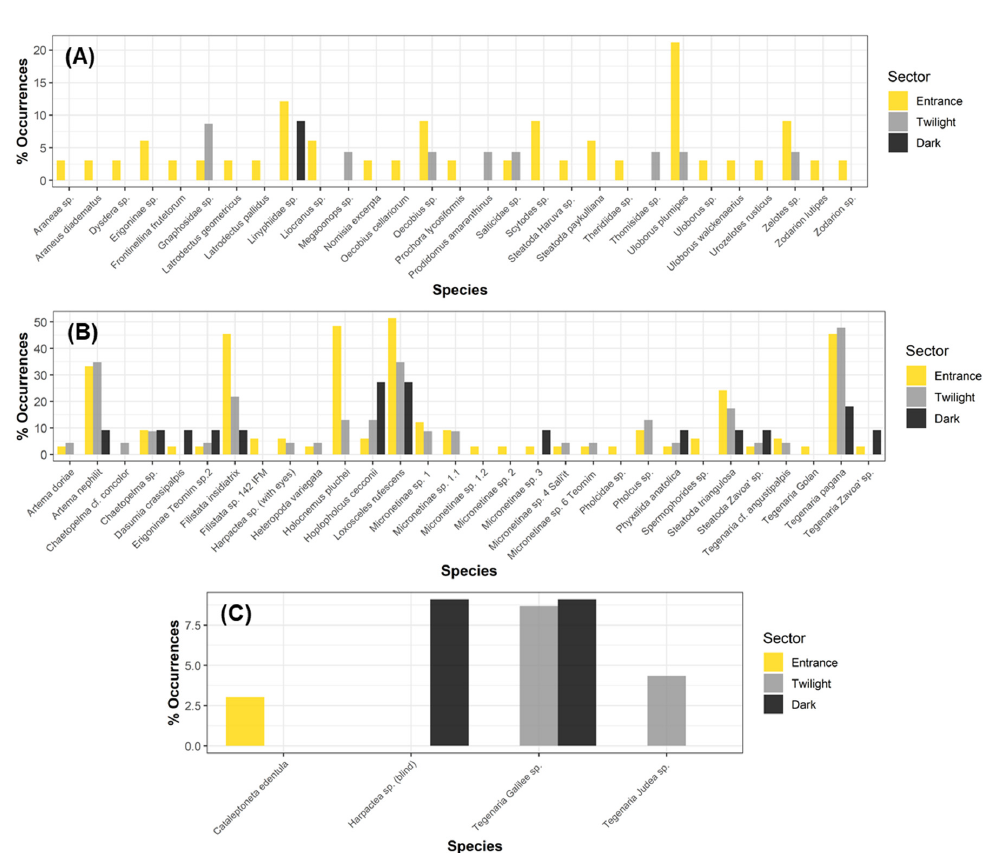
Figure 3. Percentage of surveys in which ( A ) accidental, ( B ) troglophile, and ( C ) troglobite species were identified across cave zones. Dark, twilight, and entrance abundances are denoted by black, grey and yellow, respectively. Occurrence is calculated as the percentage of surveys of a zone type that found at least one individual of each species.